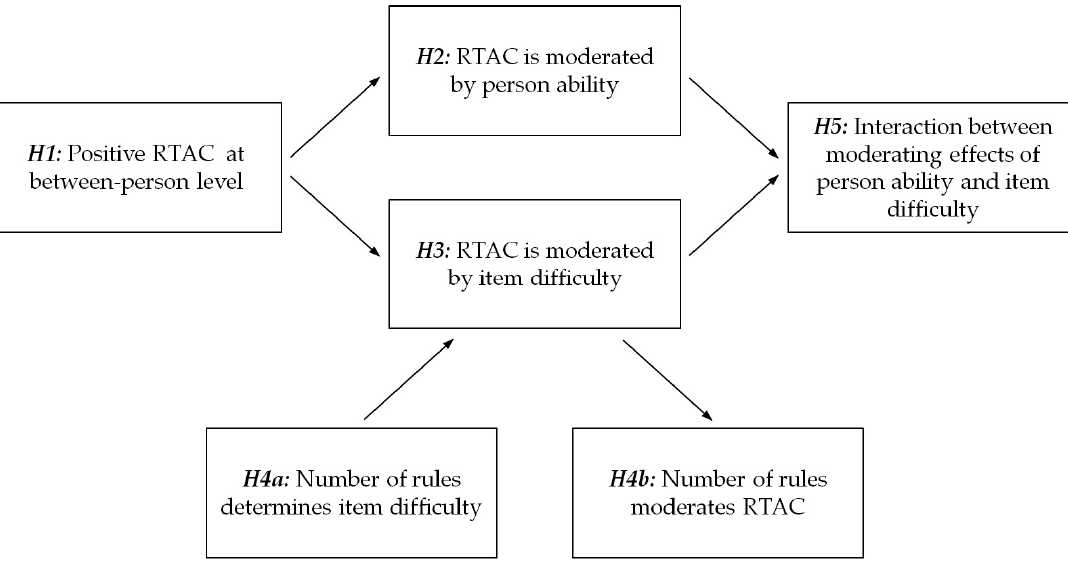
Figure 2. Hypotheses of the current study.